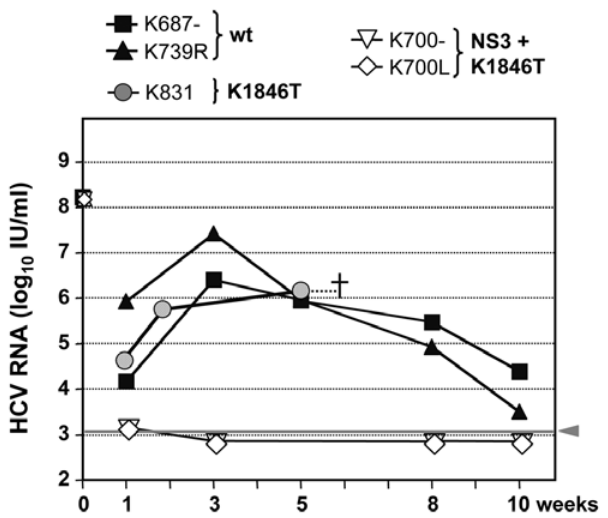
Figure 7. Invivo infectivity of Con1/wt, Con1/K1846T and Con1/ NS3 + K1846T genomes in uPA-SCID mice. Huh7-Lunet cells were transfected with either of these constructs, supernatants were collected 12 and 24 h post transfection, pooled for each construct and used for virus purification and concentration as described in Materials and Methods. Two mice were each inoculated with 2 6 10 8 IU HCV RNA per mouse and construct (100 m l inoculum size) and viral RNA loads in sera were determined at the indicated time points after inoculation by qRT- PCR. In case of Con1/K1846T inoculated mice, one died at week 2 (not shown) and the second shortly after week 6. While sera of Con1/wt and Con1/K1846T inoculated mice contained high viral loads already in the first blood sample, Con1/NS3 + K1846T-inoculated mice remained HCV RNA negative throughout the 10 weeks observation period.